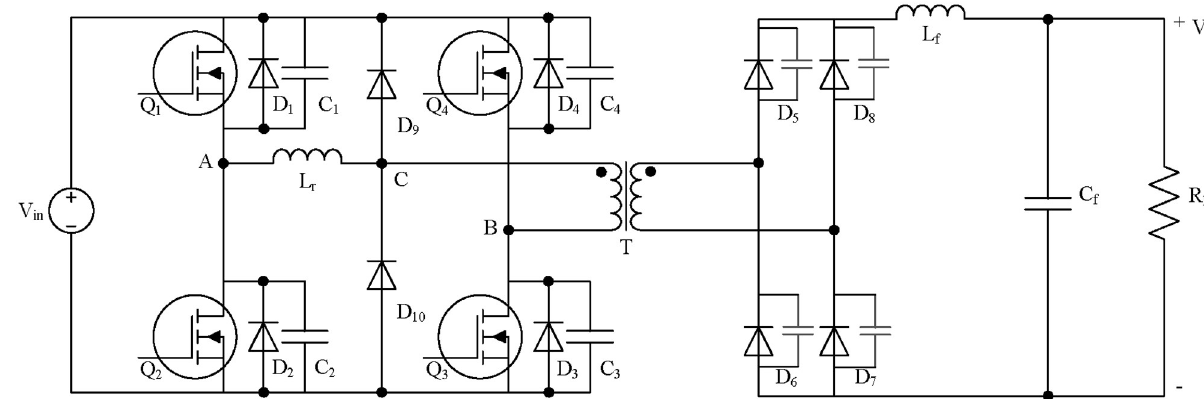
Fig 5. Full-Bridge DC/DC converter with primary clamping